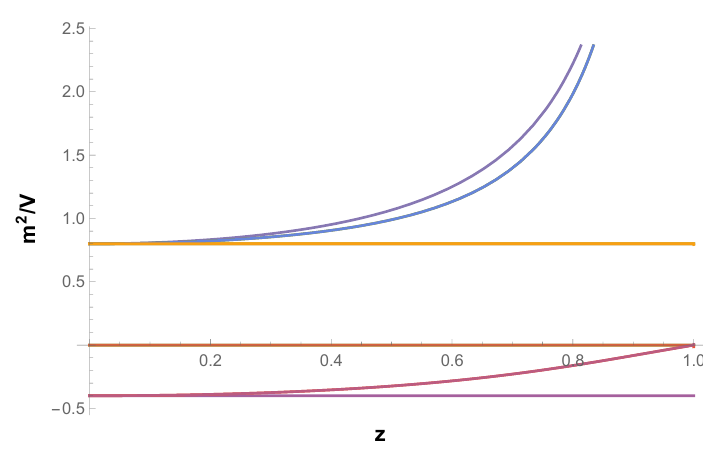
Figure 1 . The ratio m 2 / V of all the scalar fields in the SU(2) × O(1,1) model, plotted as a function of the modulus z = Im z 2 . The central vacuum z = 0 preserves the full SU(2) gauge group. Tachyons with m 2 / V = − 2 / 5 are present for all values of z